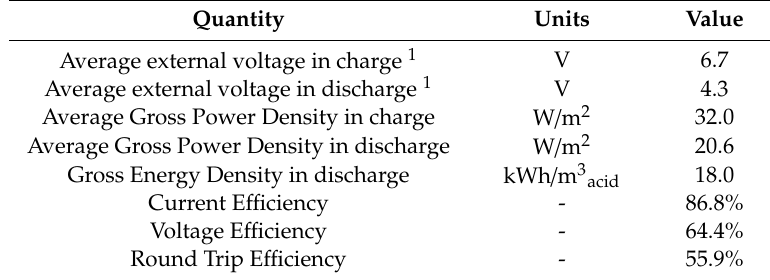
Table 3. Main results predicted by the simulation of the pilot plant. The current density was fixed at 100 A / m 2 for both charge and discharge.